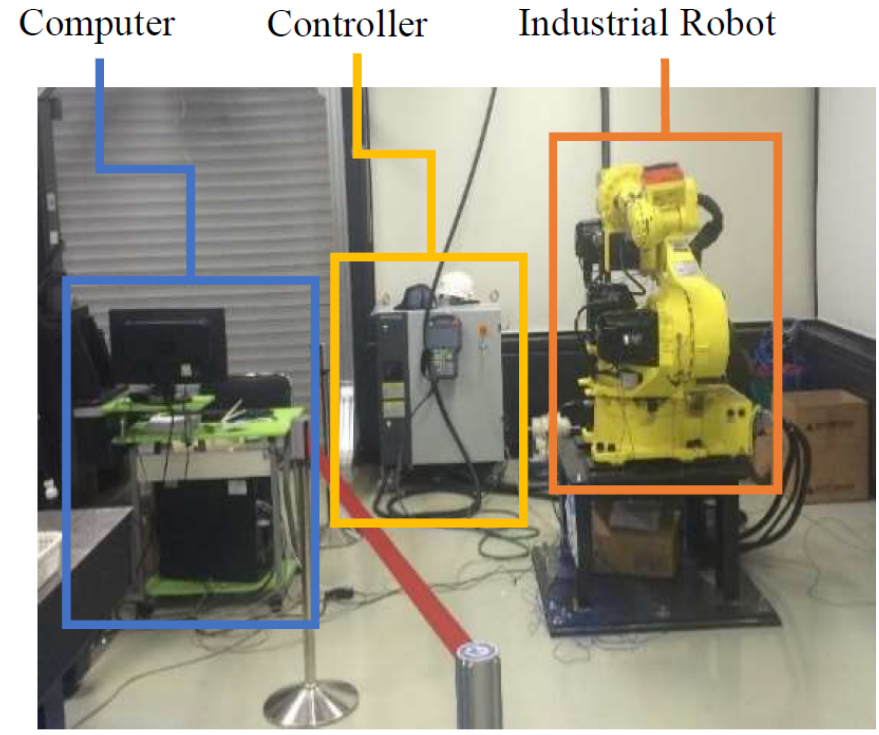
Figure 4. Experimental Setup for Hyundai Robot